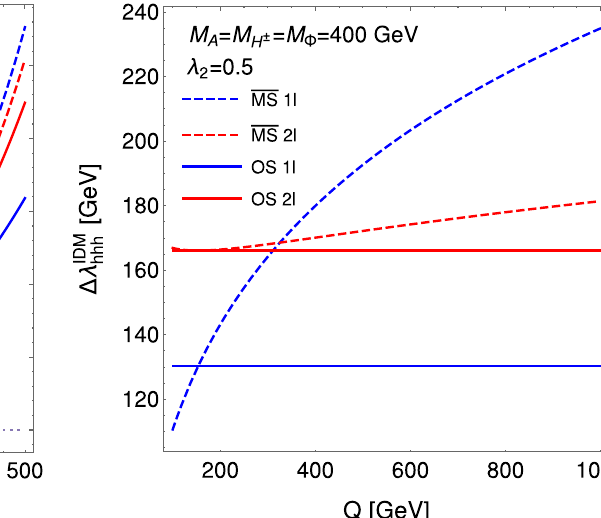
Fig. 10 Comparison of the BSM corrections Δλ IDM calculatedatone-andtwo-looporders(blueandredcurvesrespectively) in the MS scheme (dashed curves) and in the OS scheme (solid curves). To obtain the MS results, we convert the OS-renormalised input param- eters ( M A , M H ± , M t , v phys ) to MS, using the expressions presented in